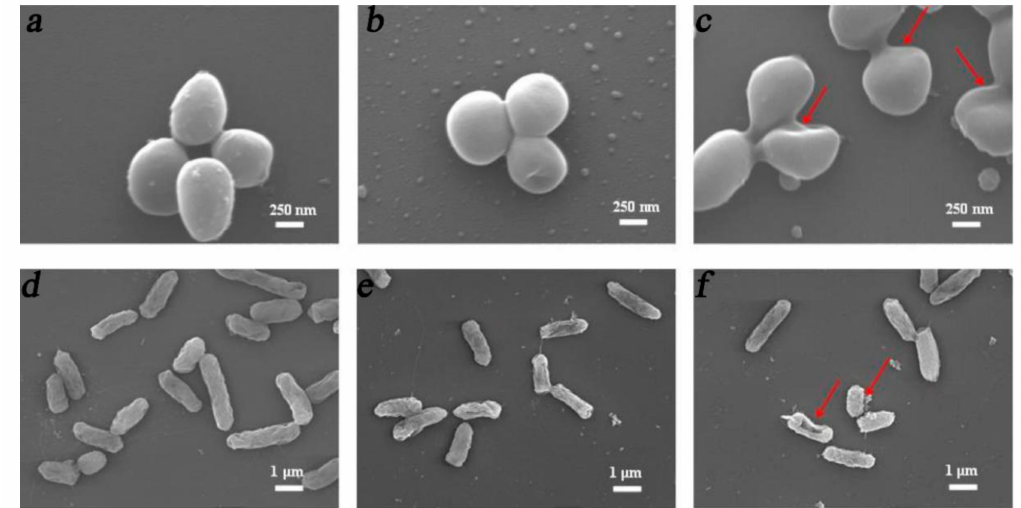
Figure 2. SEM images of S. aureus ( a – c ) and E. coli ( d – f ) after culture on PVA/CuS/MoS 2 hydrogels with NIR/visual light irradiation for 15 min. ( a , d ) PVA hydrogel, ( b , e ) CuS incorporated PVA hydrogel, and ( c,f ) CuS/MoS 2 -incorporated PVA hydrogel [104]. Copyright 2020,